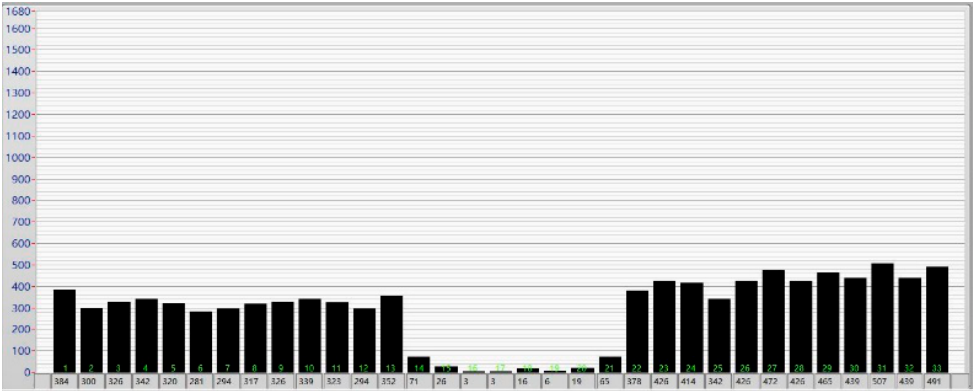
Figure 16. The disappearance of the shape signal.